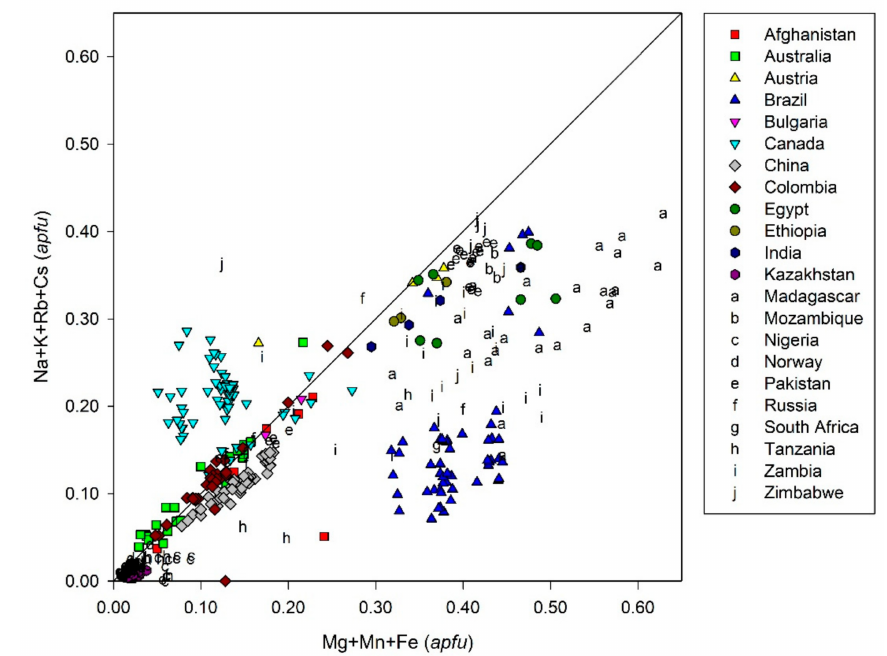
Figure 7. Mg + Mn + Fe vs. monovalent channel-site cations, in atoms per formula unit, for analyses from the literature. Sources of data are the same as in Figure